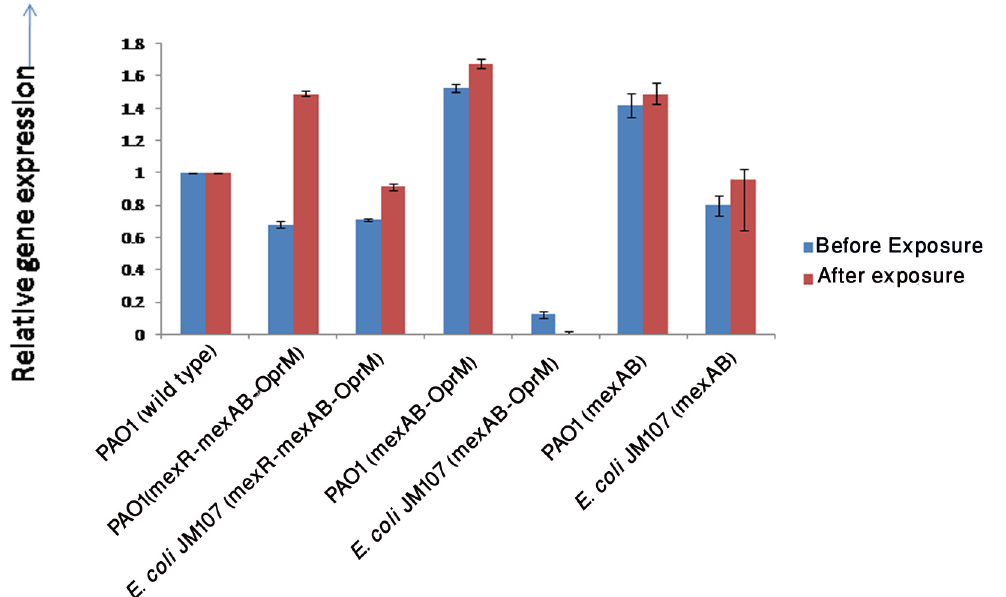
Fig 3. Expression of mexA gene before and after single dose exposure in